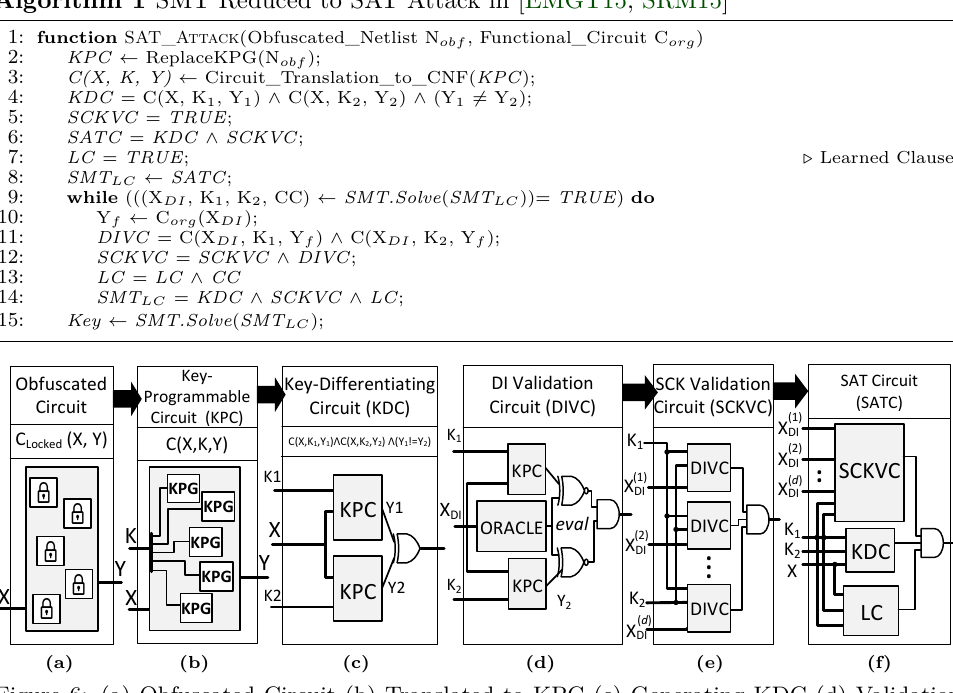
Algorithm 1 SMT Reduced to SAT Attack in [EMGT15, SRM15]